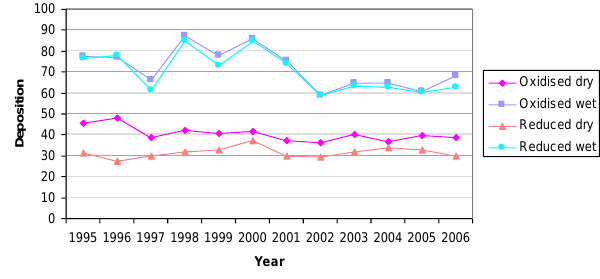
Fig 8 . Comparison of relative annual wet deposition and relative annual precipitation in the period 1995 - 2006. Units: Percent of 1995 annual value.